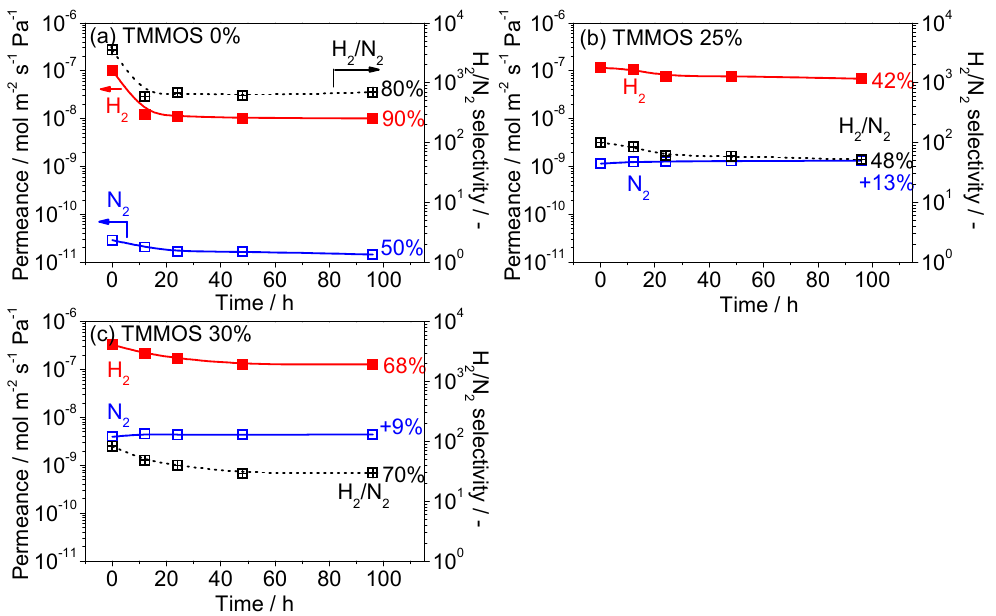
Figure 12. Hydrothermal stability test (permeance versus exposure time) at 16 mol% H 2 O vapor and 650 °C for 96 h, the percentages are calculated by (initial value − final value)/(initial value). ( a ) TMMOS 0%, ( b ) TMMOS 25%, and ( c ) TMMOS 30%.